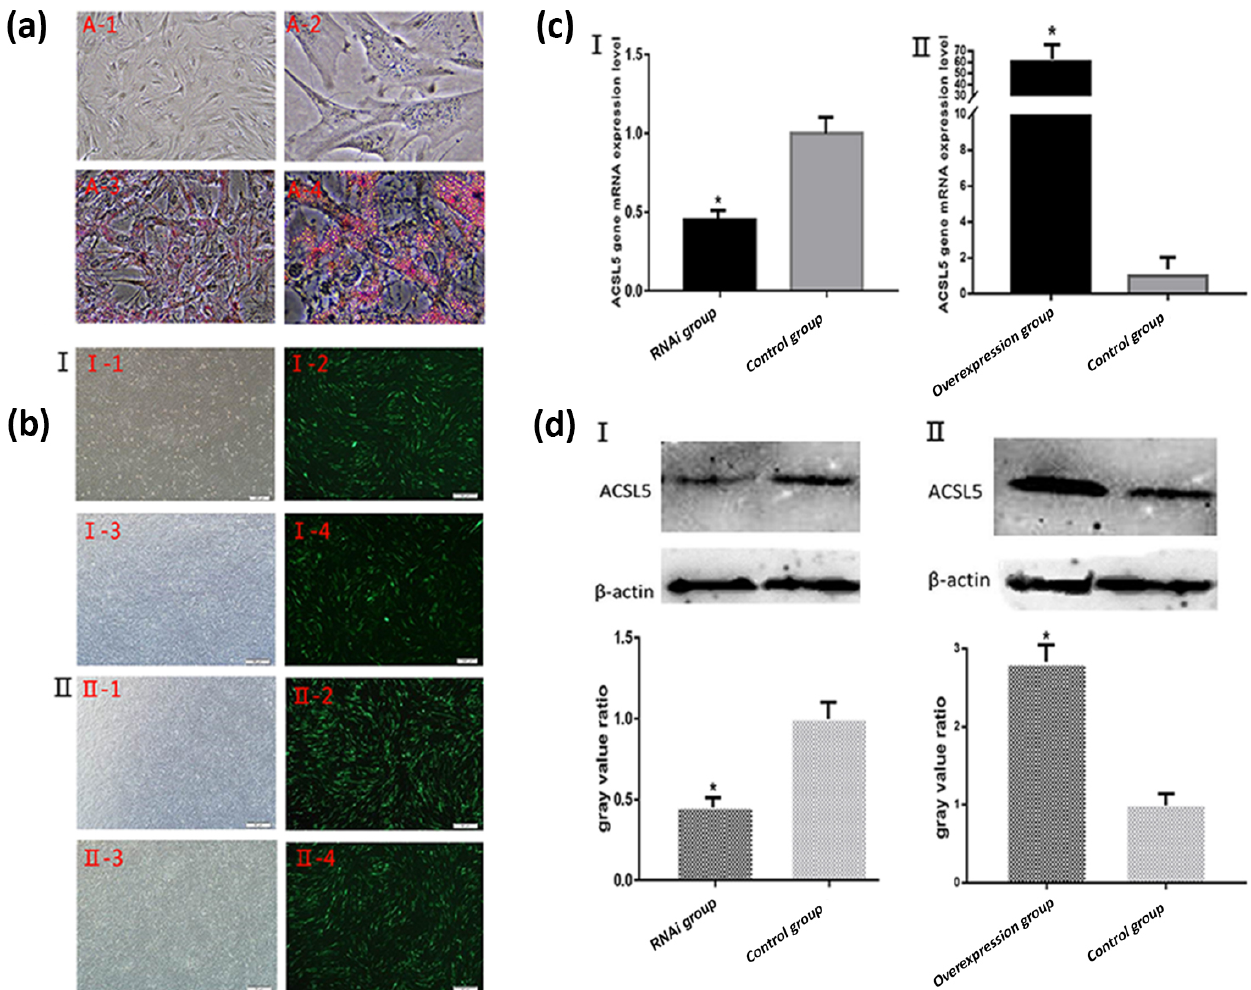
Figure 3. Oil Red O staining of bovine preadipocyte and fluorescence detection and the expression levels of ACSL5 mRNA and protein. (a) A-1: Undifferentiated bovine preadipocytes (unstained, 200 × ); A-2: undifferentiated bovine preadipocytes (unstained, 400 × ); A-3: dif- ferentiated bovine preadipocytes (stained, 200 × ); A-4: differentiated bovine preadipocytes (stained, 400 × ). (b) Fluorescence detection of bovine preadipocytes transfected with shRNA- ACSL5 and pBI-CMV3- ACSL5 . I-1: shRNA- ACSL5 -transfected bovine preadipocytes (visible light); I-2: shRNA- ACSL5 -transfected bovine preadipocytes (fluorescence); I-3: negative control vector-transfected bovine preadipocytes (visible light); I-4: negative control vector-transfected bovine preadipocytes (fluorescence). II-1: pBI-CMV3- ACSL5 -transfected bovine preadipocytes (visible light); II-2: pBI-CMV3- ACSL5 -transfected bovine preadipocytes (fluorescence); II-3: negative control vector- transfected bovine preadipocytes (visible light); II-4: negative control vector-transfected bovine preadipocytes (fluorescence). (c) The ex- pression level of ACSL5 mRNA in bovine preadipocytes. c-I: the expression level of ACSL5 mRNA in bovine preadipocytes transfected with the shRNA- ACSL5 and pGPU6/GFP/Neo plasmids. c-II: the expression level of ACSL5 mRNA in bovine preadipocytes transfected with pBI-CMV3- ACSL5 and pBI-CMV plasmids. (d) The expression level and the gray value ratio of ACSL5 protein in bovine preadipocytes. D-‡T: the expression level and the gray value ratio in bovine preadipocytes transfected with shRNA- ACSL5 and pGPU6/GFP/Neo plasmids. D-‡U: expression level and the gray value ratio in bovine preadipocytes transfected with pBI-CMV3- ACSL5 and pBI-CMV